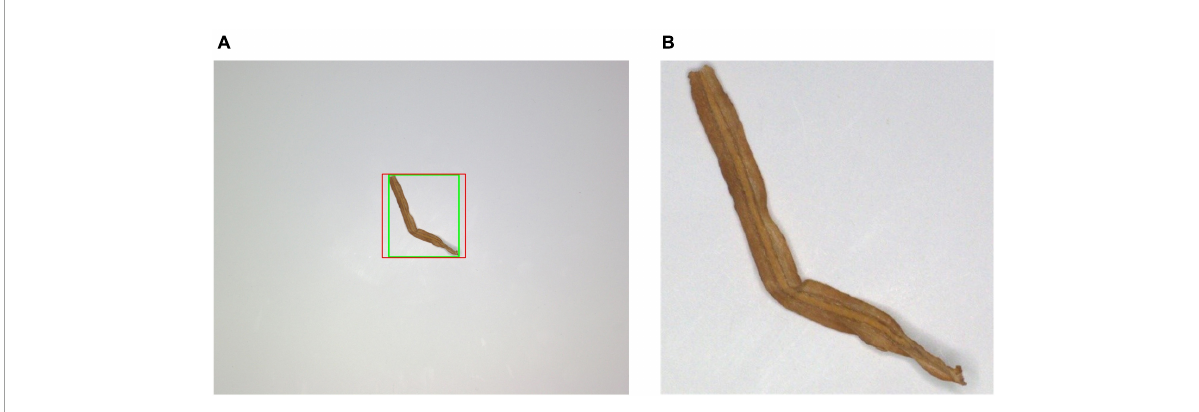
FIGURE11 Result of tobacco shred image segmentation (A) cropped ROI outline (B) segmented tobacco shred image through